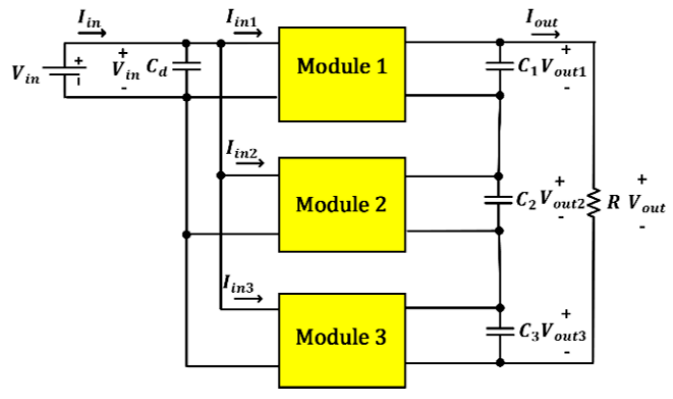
Figure 5. Input-Parallel Output-Series (IPOS) DC-DC converter circuit diagram.